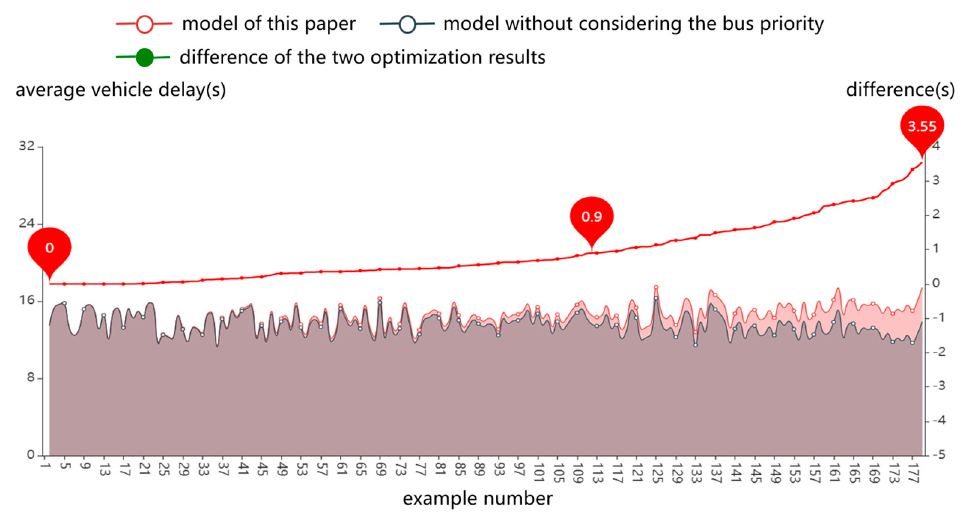
Figure 16. Comparison of the average vehicle delay after the optimization of the two models.